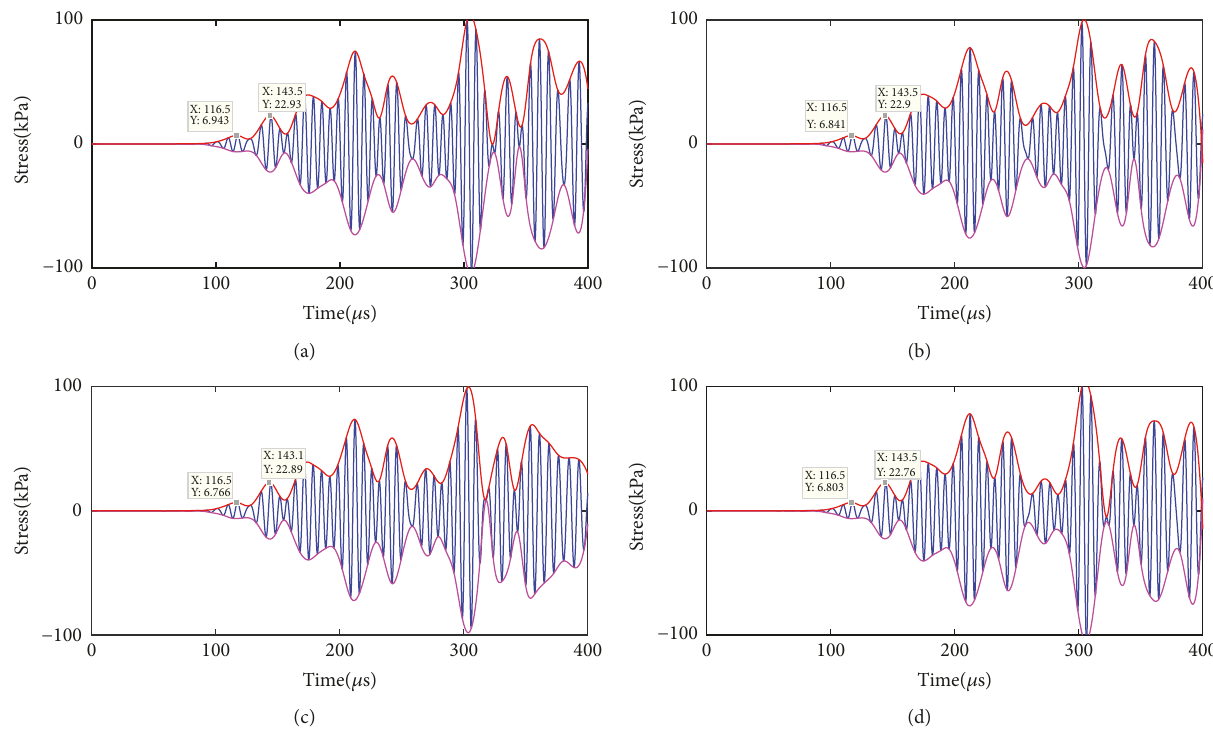
Figure 11: Collected signals of stress collection points (a) no. 1, (b) no. 2, (c) no. 3, and (d) no. 4 when the rotor rotates at